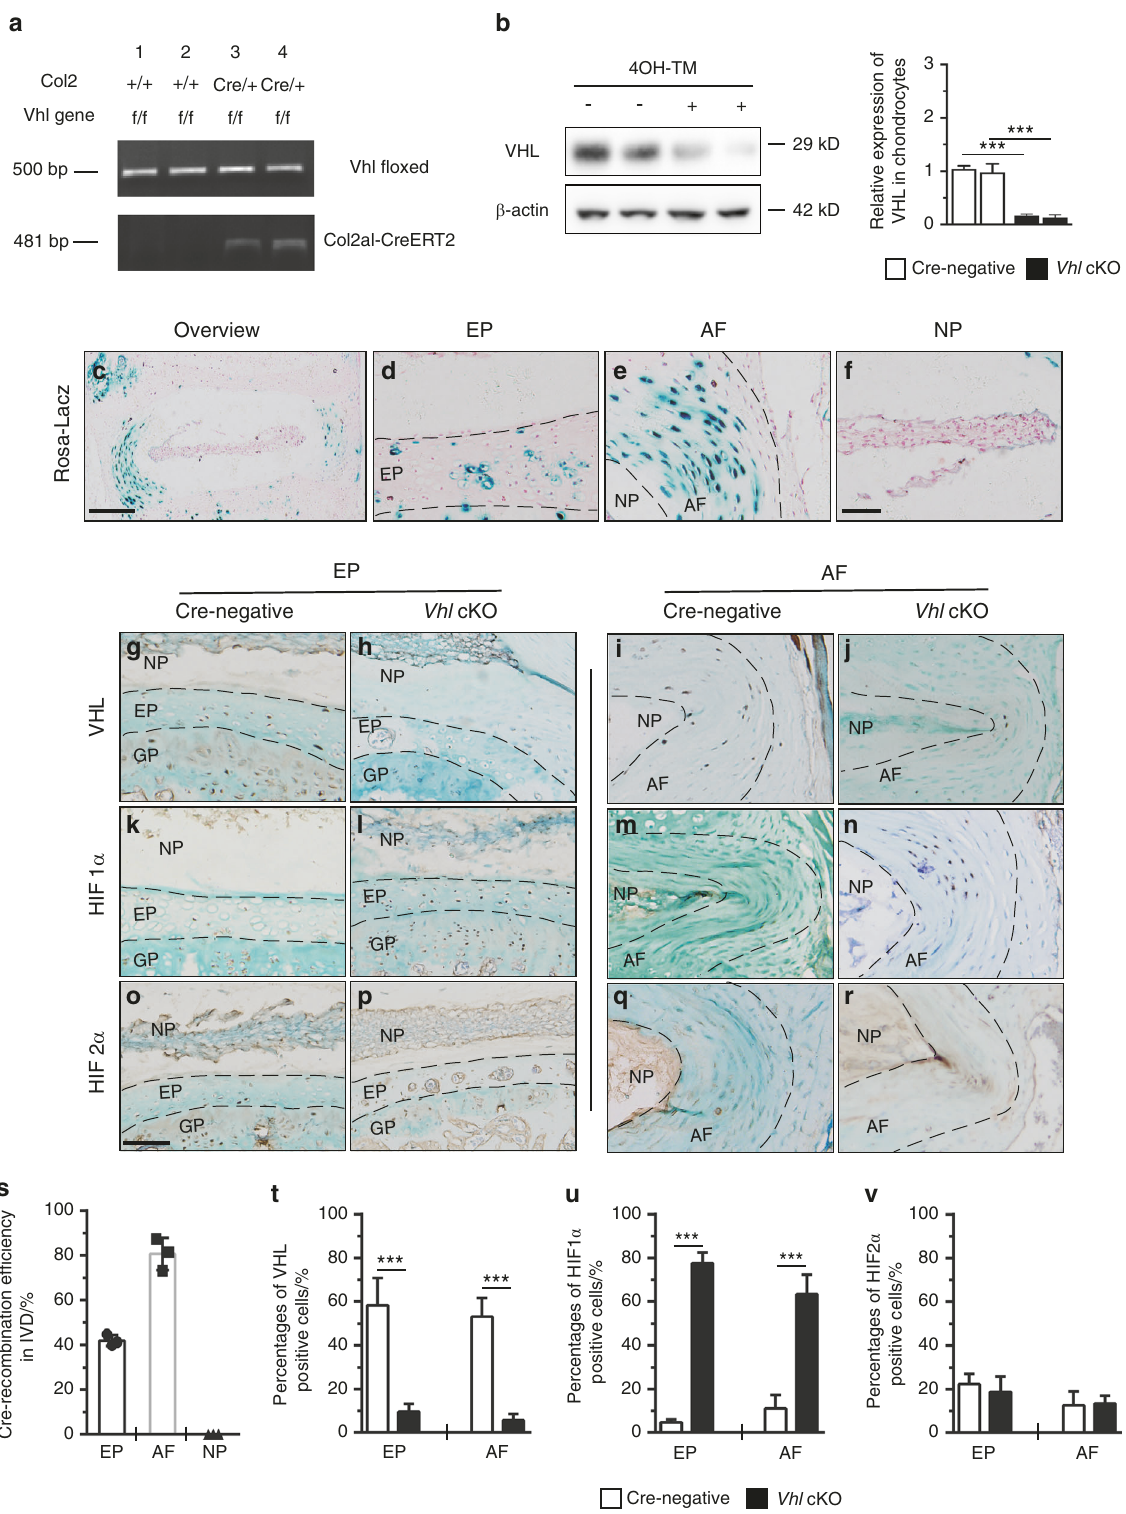
Fig. 2 Conditional deletion of Vhl in EP and AF cells leads to aberrant Hif1 α activation in mouse IVDs. a Polymerase chain reaction (PCR) for genotyping Vhl fl ox/ fl ox Col2a1-CreERT 2 ( Vhl cKO) mice. b VHL protein expression in response to tamoxifen (TM) treatment in primary IVD cells from Vhl fl ox/ fl ox Col2a1-CreERT 2 mice, as determined by western blotting. c – f Lac-Z staining detecting the Cre-mediated recombination ef fi ciency in IVD cells of Col2a1-CreERT 2 ; Rosa26 mice at 4 months of age ( n = 5 per group). ( g – r ) Immunohistochemistry analysis of VHL, HIF1 α and HIF2 α in the EP and AF of Vhl cKO and control mice ( n = 5 per group). s Quantitative analysis of the Cre recombination ef fi ciency in IVD cells. t – v Quantitative analysis of VHL + cells and HIF1 α + and HIF2 α + cells in the EP and AF of Vhl cKO and control mice. Scale bar: 100 µm ( c ), 50 µm ( d – r ). Data are expressed as the percent expression relative to controls. Values represent the mean (symbols) ± SD (error bars). *P < 0.05 ; **P < 0.01 ; ***P < 0.001